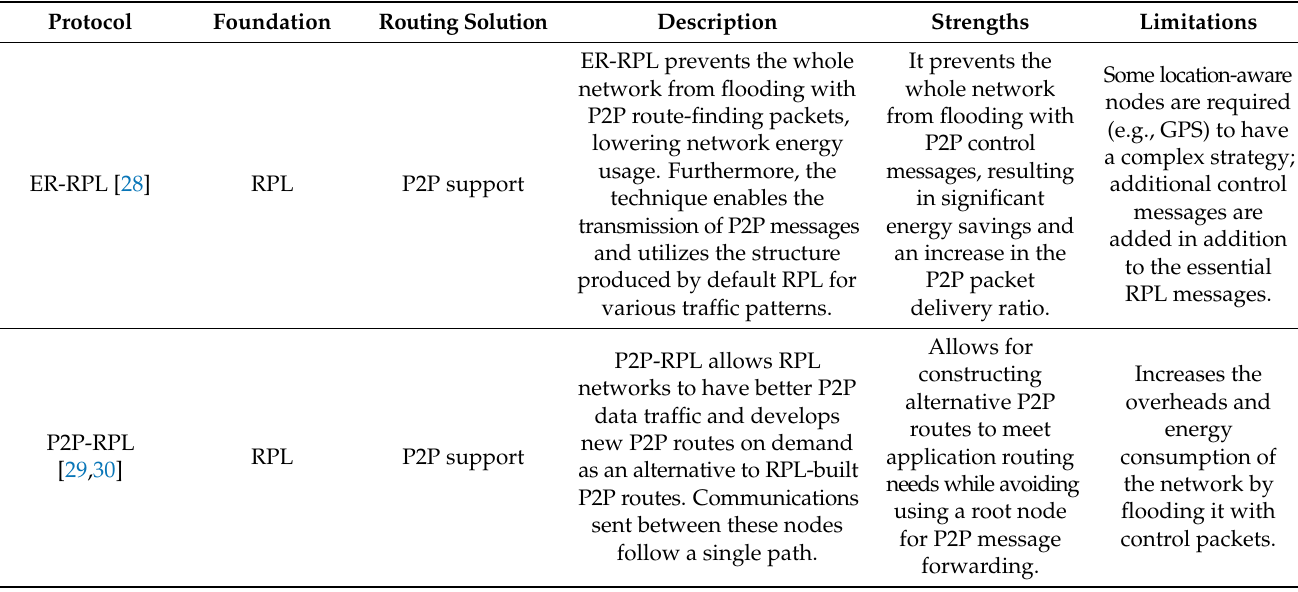
Table 1. Effective low-powered and LLN protocols in IoT